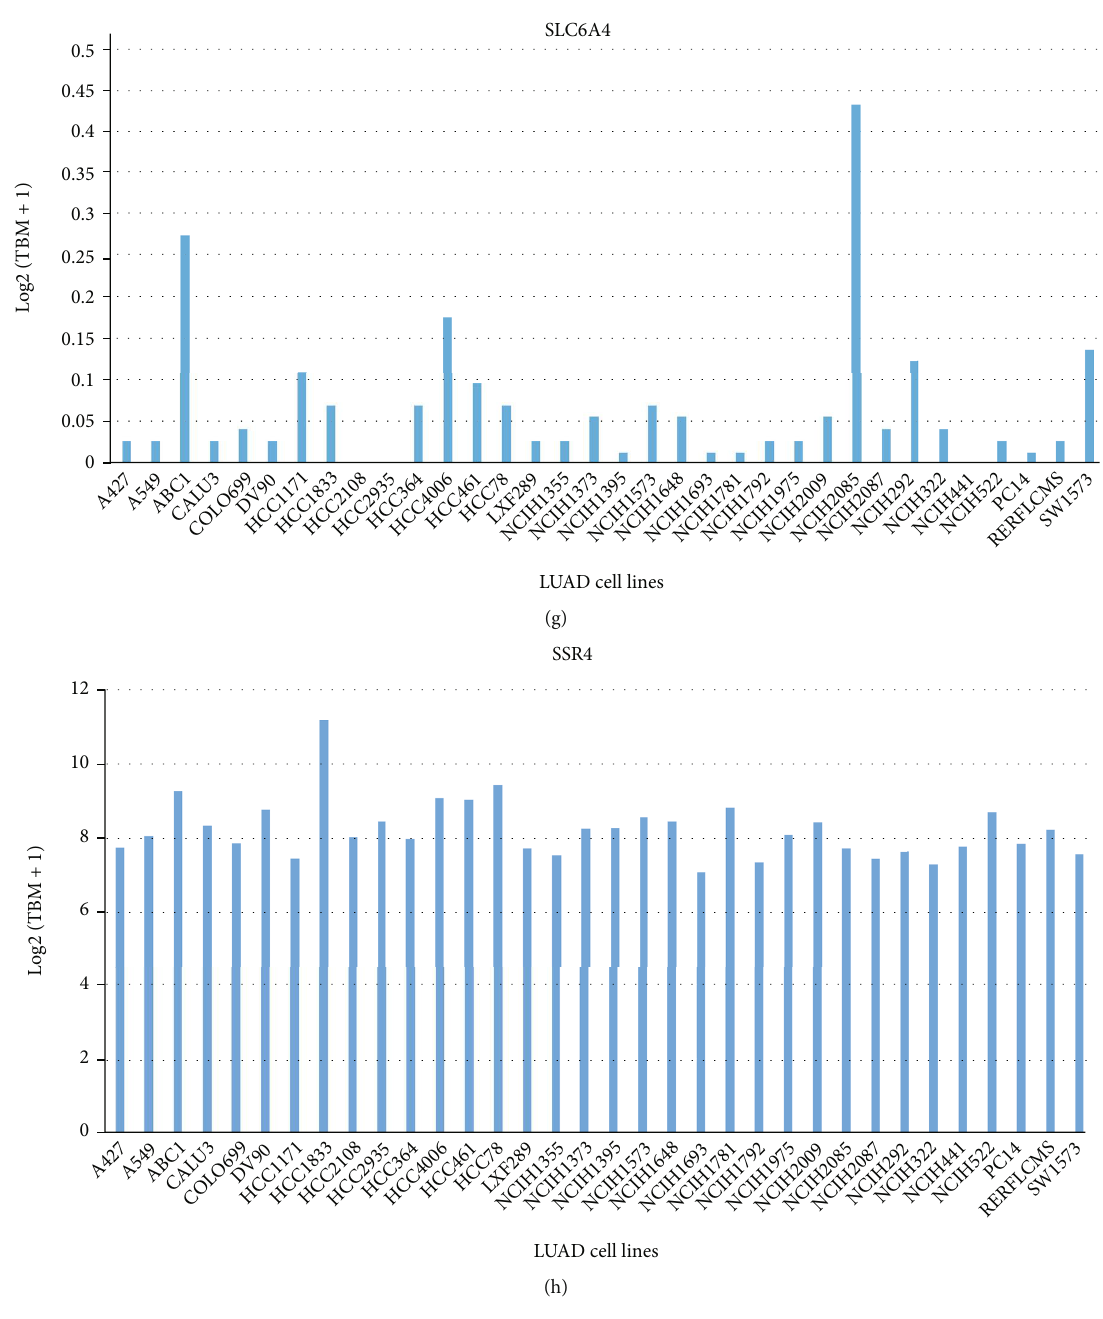
Figure 9: Gene expression in di ff erent LUAD cell lines. (a) ADRB2. (b) AGER. (c) CDKN3. (d) GJB2. (e) SFTPC. (f) SLC2A1. (g) SLC6A4. (h)